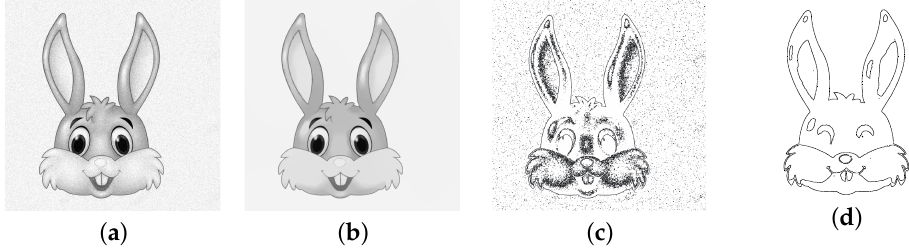
Figure 3. The results of the our proposed method with poission noise. ( a ) The original images with poission noise. ( b ) The smoothing images by the proposed method. ( c ) The contour line of ( a ). ( d ) The contour line of ( b